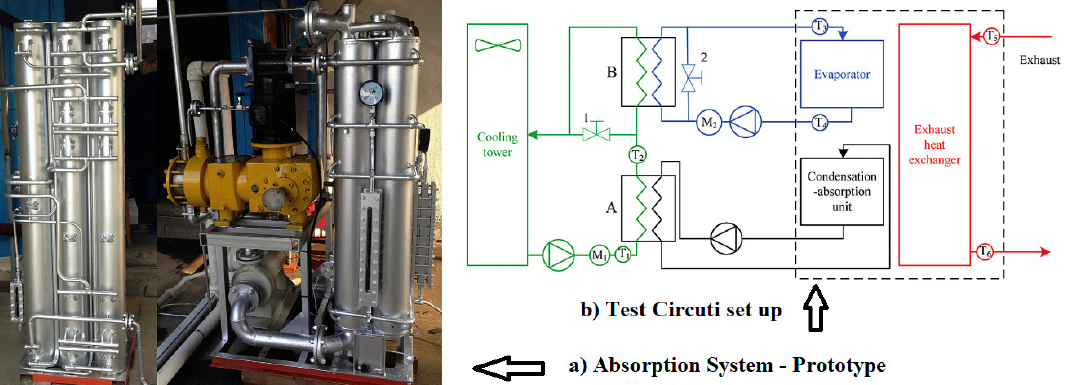
Figure 4. Absorption refrigeration prototype [3] (Reprinted with permission from Elsevier).